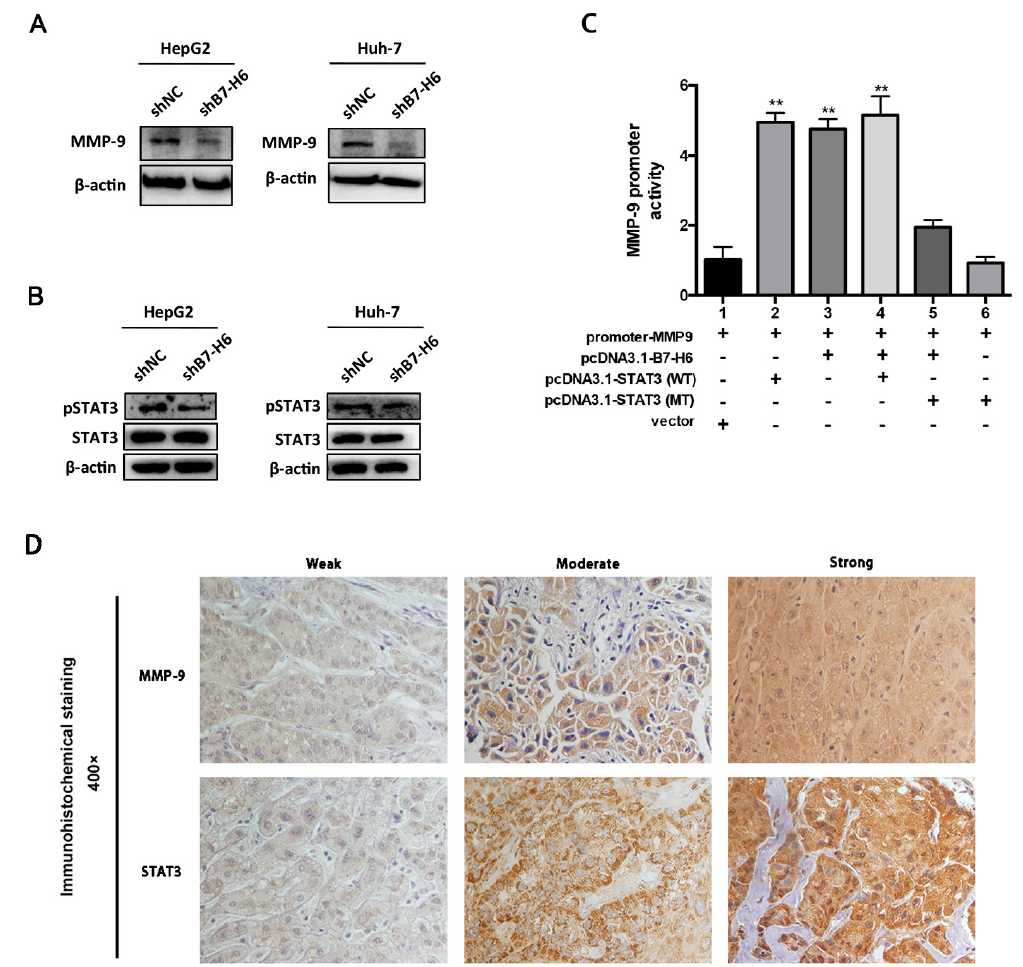
Figure 9. Knockdown of B7-H6 in HCC cells inhibits MMP-9 expression and STAT3 activation. ( A ) Expression of MMP-9 was reduced in HepG2-shB7-H6 and Huh-7-shB7-H6 cells compared with negative control cells, respectively. ( B ) Knockdown of B7-H6 inhibited phosph-STAT3 (p-STAT3) expression in both Huh-7 and HepG2 cells. ( C ) The activity of the MMP-9 promoter was tested by Luciferase reporter assay in Huh-7 cells. MMP-9/Luc promoter-reporter construct was transfected into Huh-7 cells alone or in combination with B7-H6-pcDNA3.1, or STAT3 (WT)-pcDNA3.1, or STAT3 (MT)-pcDNA3.1 expression plasmids, or pcDNA3.1 empty vector. After transfection for 48 h, the luciferase activity was measured. ** p < 0.01, Student’s t -test. ( D )